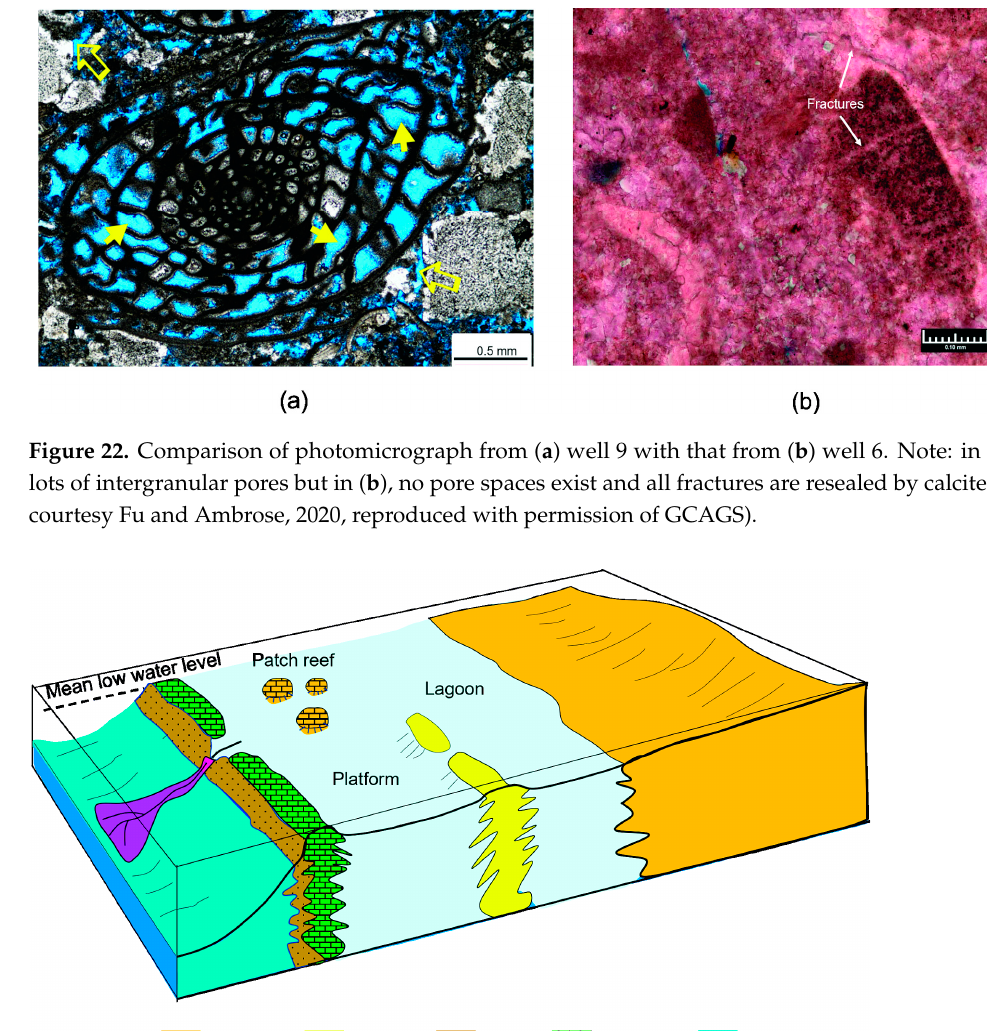
Figure 21. Photomicrographs of core samples showing ( a ) intragranular pores (solid yellow arrow) within fusulinids and minor intergranular pores (hollow arrow) at depth of 5329 ft (1624.2 m) in well 9. ( b ) Abundant vugs (v) in well 10 at depth of 5215.9 ft (1589.7 m) (Fu and Ambrose, 2020, reproduced with permission of GCAGS).